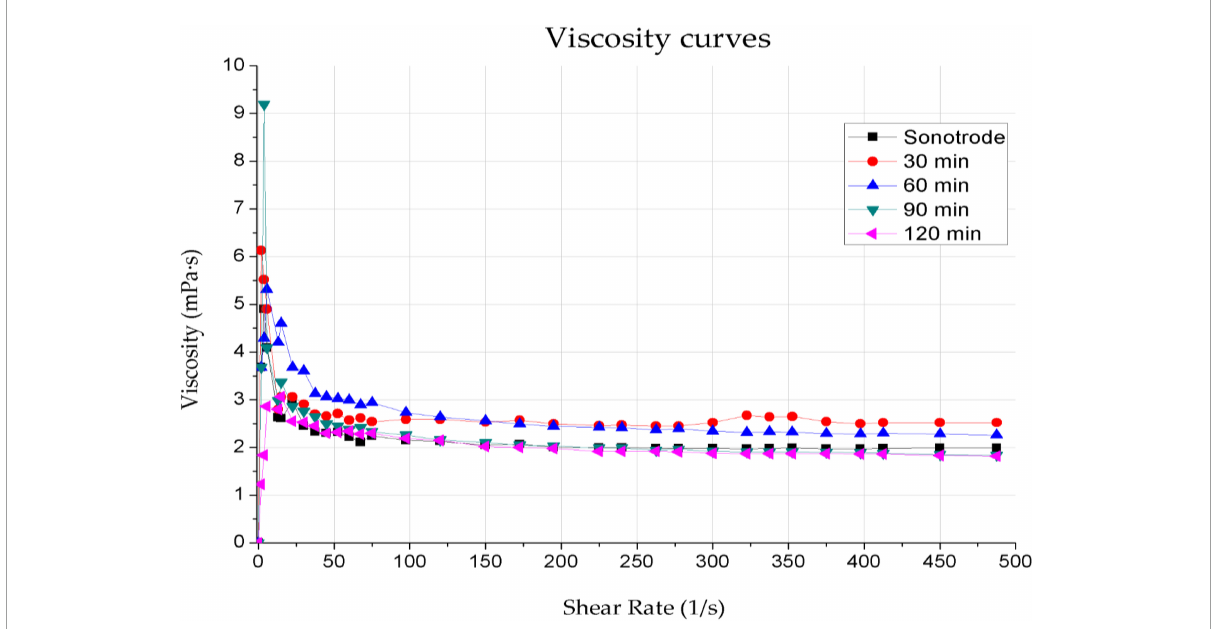
FIGURE2 Dependence of viscosity on shear rate for graphene inks with sonication times of 30, 60, 90, and 120 min using an ultrasonic bath and 1 min using a sonotrode.